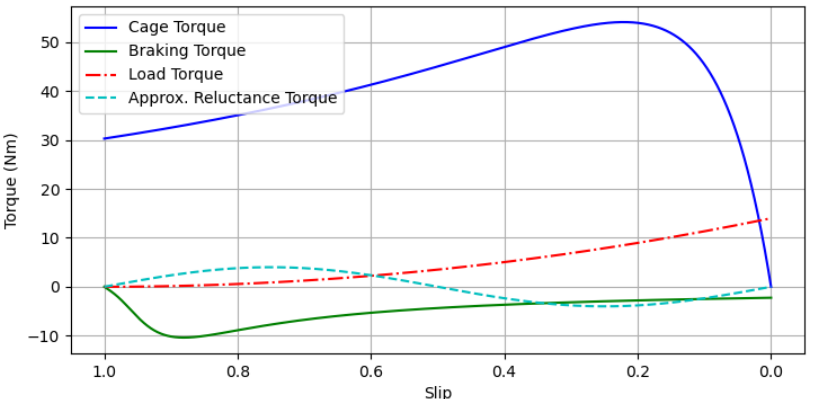
Figure 2. Various torque components during the asynchronous operation of a LSPMSM.